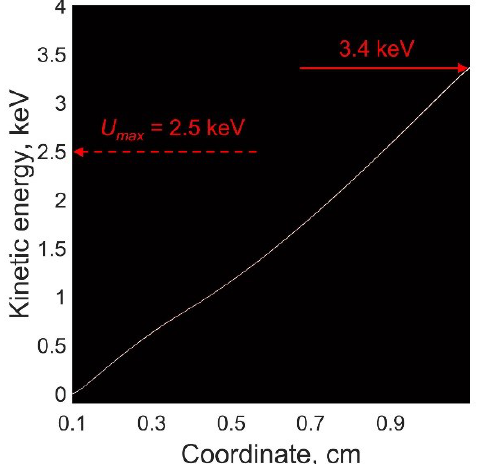
Figure 6 – Electron distribution function density plot at 0.5 ns for the axially-symmetric vacuum